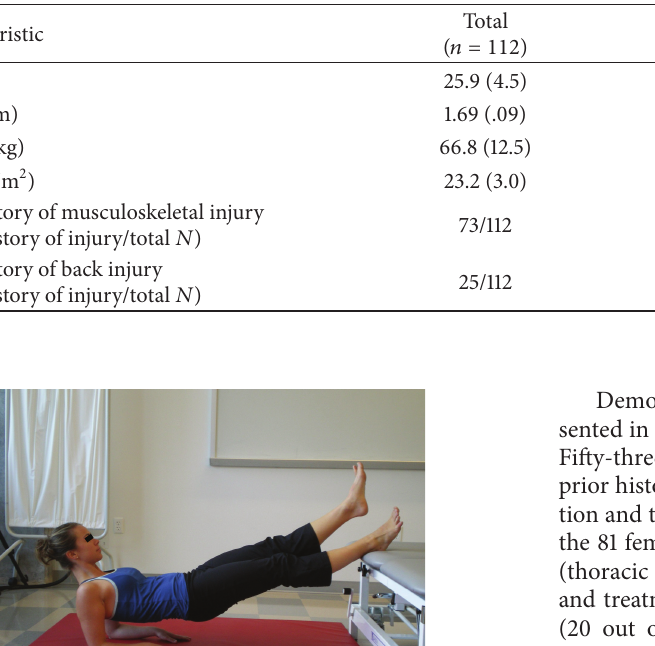
Table 1: Demographic characteristics (mean ± SD).